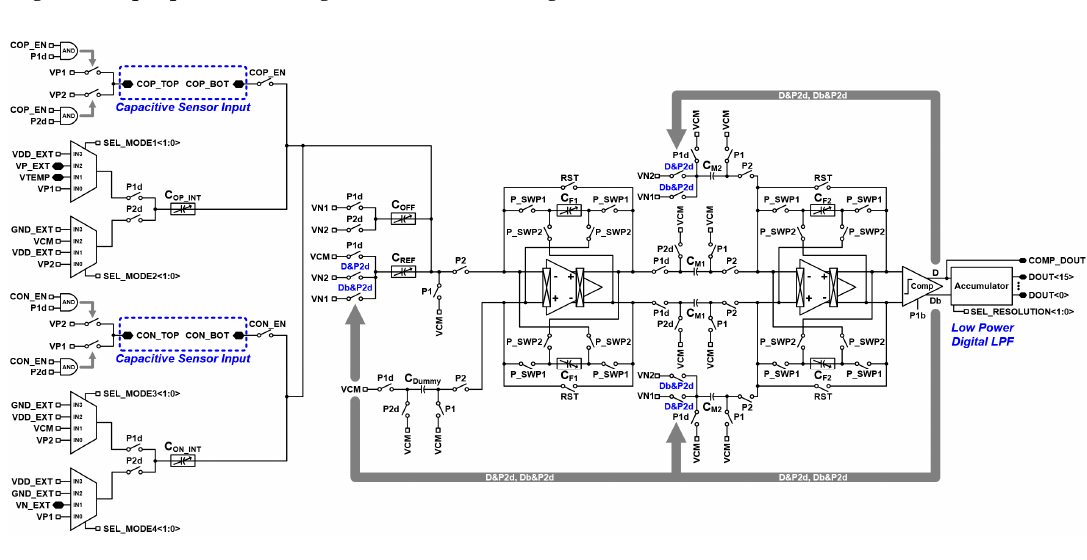
Figure 2. Schematic of the second-order delta-sigma CDC.